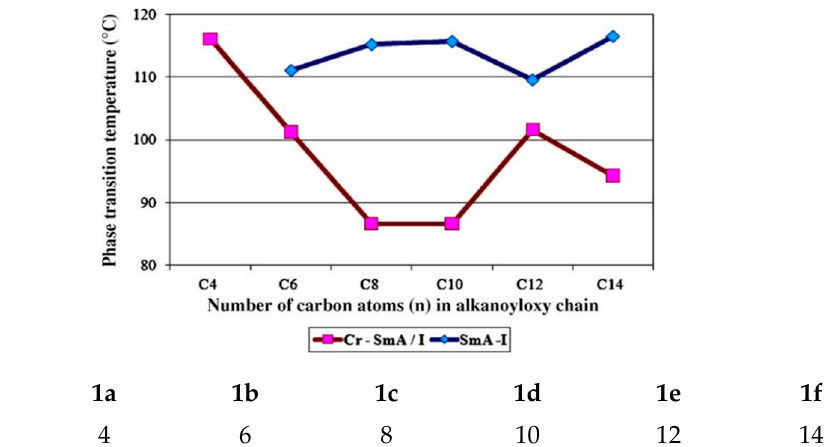
Figure 3. A plot of phase transition temperatures against a number of carbon atoms ( n ) in the alkanoyloxy chain. Reprinted/adapted with permission from Ref. [25]; published by Elsevier, 2011. In 2012, Ha et al., synthesized azomethine liquid crystals with different terminal chain lengths. The results showed that n-octanoyloxy exhibits enantiotropic smectic A